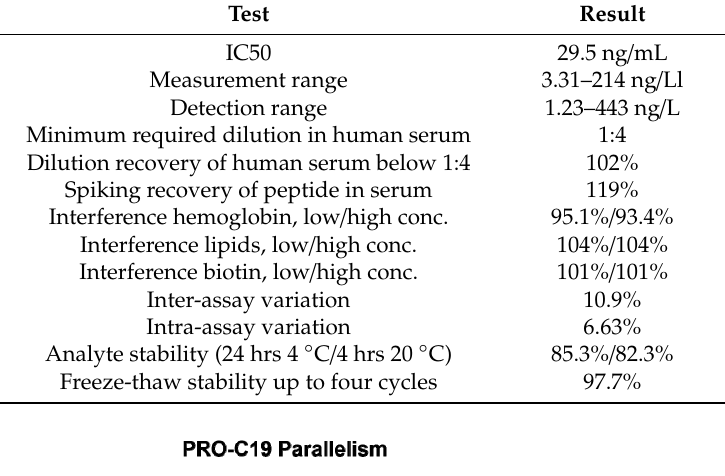
Table 1. Summary of the technical validation of PRO-C19. 97